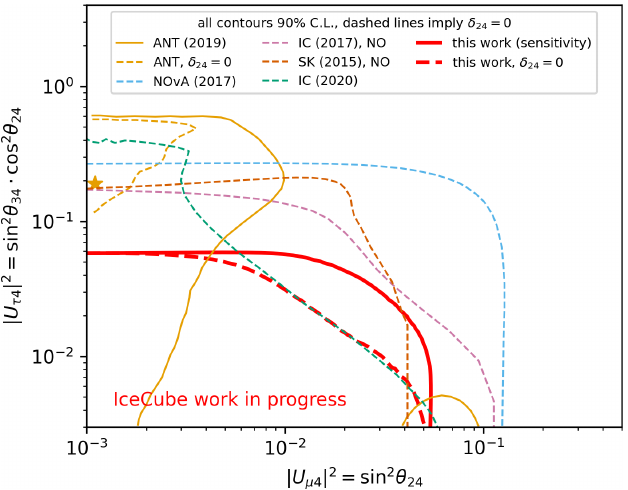
probability without low-pass filtering (left) and with low-pass filtering below the Figure 2 . Muon survival horizon (right) in the presence of a sterile neutrino with Δ 𝑚 2 nuSQuIDS nodes are placed with increased density. panel indicate where